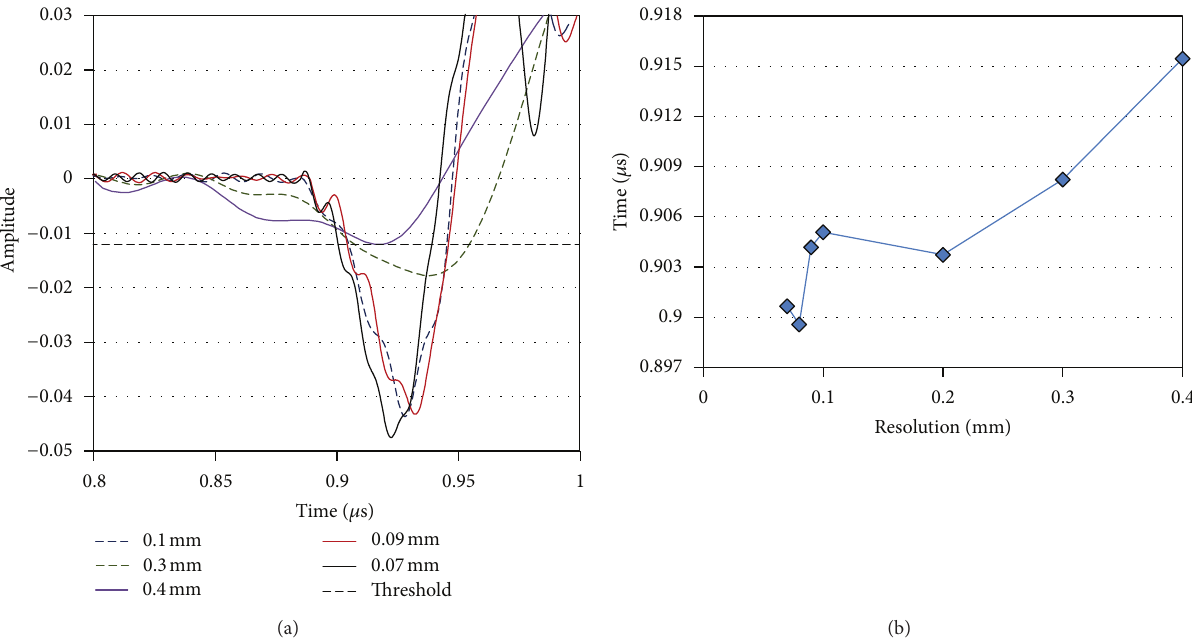
Figure 3: (a) Onset of the reflection in the received waveform for different resolutions. (b) Arrival time to the receiver for different resolutions (measured from the threshold crossing at 0.012u.a.).